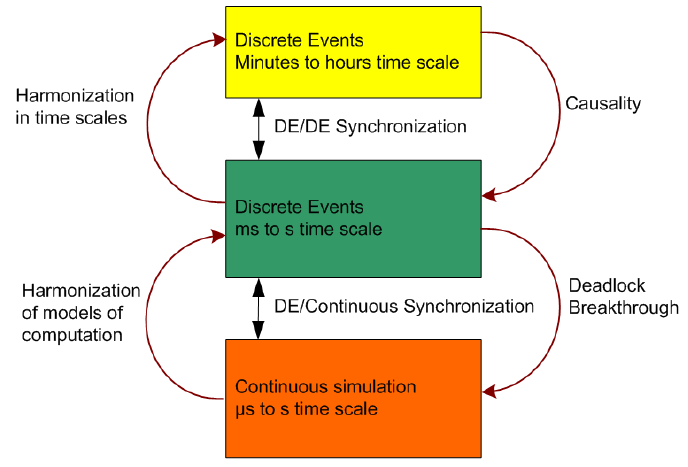
Figure 4. Illustration of dynamic layer of a CPES co-simulation